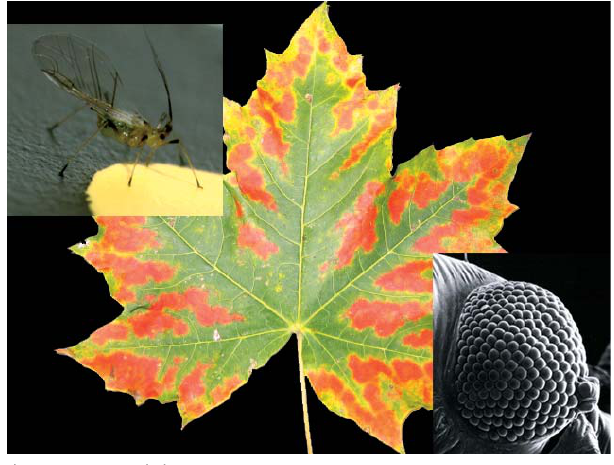
Figure 1. Autumn Tree Colors as Warning Signals to